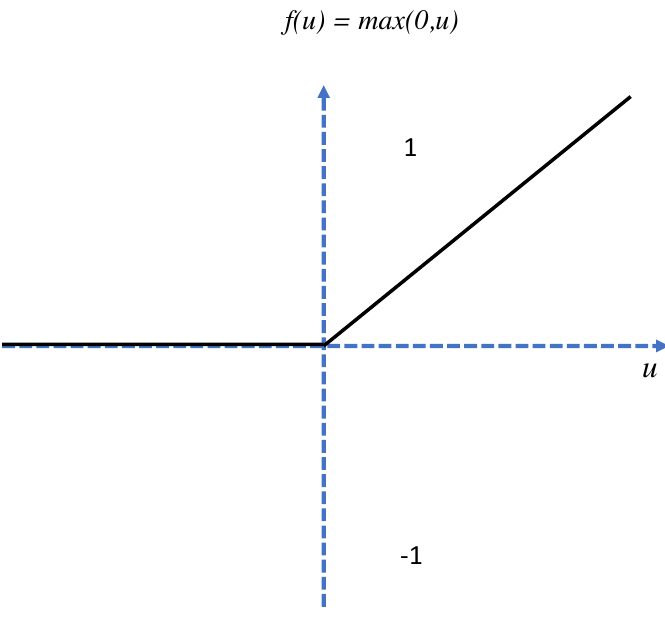
Figure 6. Re-Lu layer.